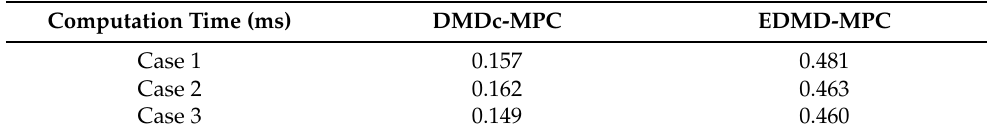
Table 6. Average computation time of DMDc-MPC and